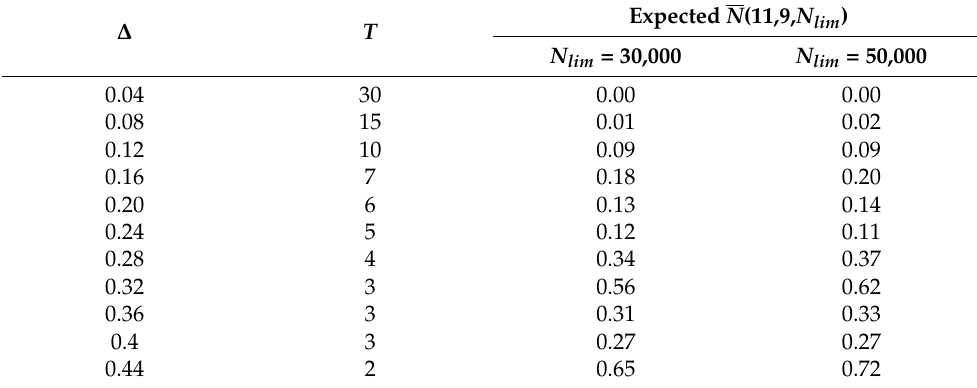
Table 6. Relative prediction error,